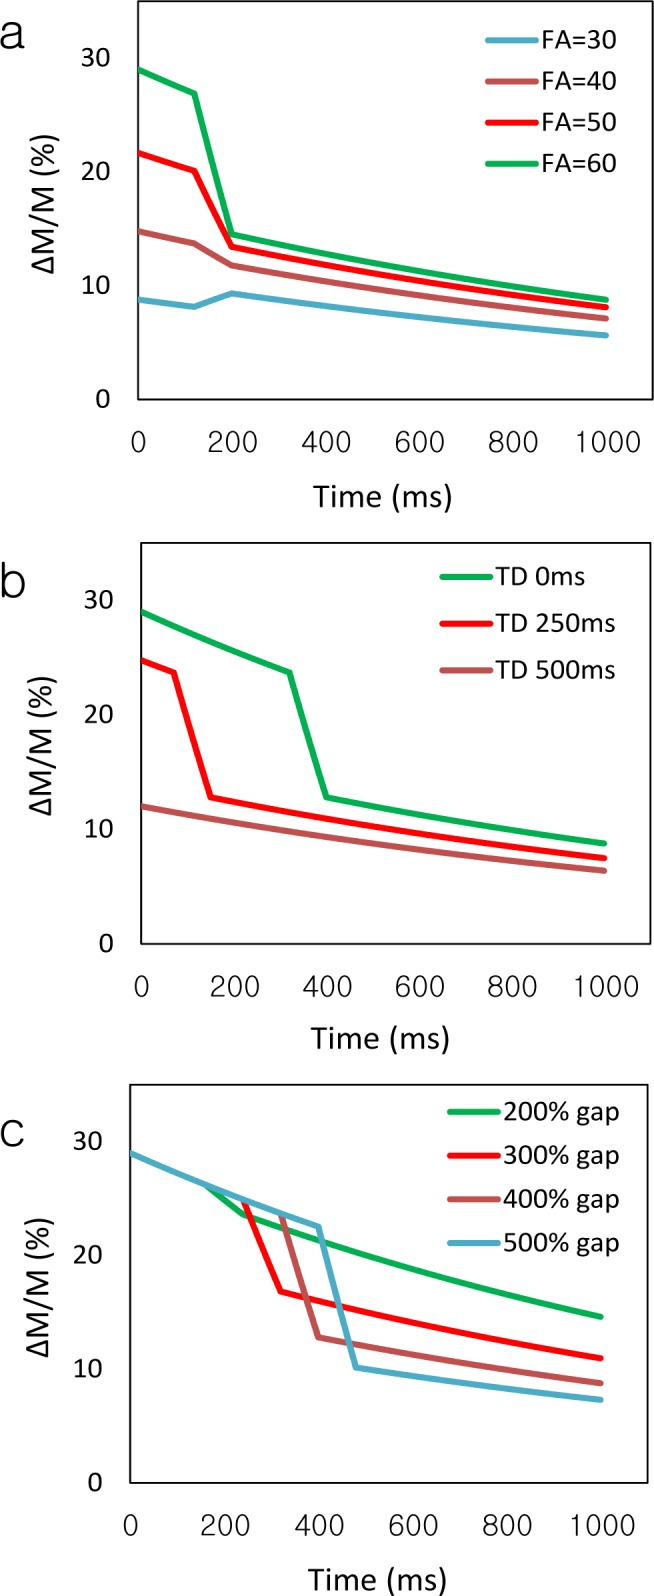
Simulation results of magnetization difference between control and labeling scans in sagittal sinus vein.The simulations were performed at various flip angles (FA) (30, 40, 50, and 60°) (a), various inter-slice delay time (TD) (0, 250, and 500 ms) (b), and various gap size (200, 300, 400, and 500% of slice thickness) (c). ΔM represents magnetization difference between control and labeling scans and M represents the signal intensity of control scan.